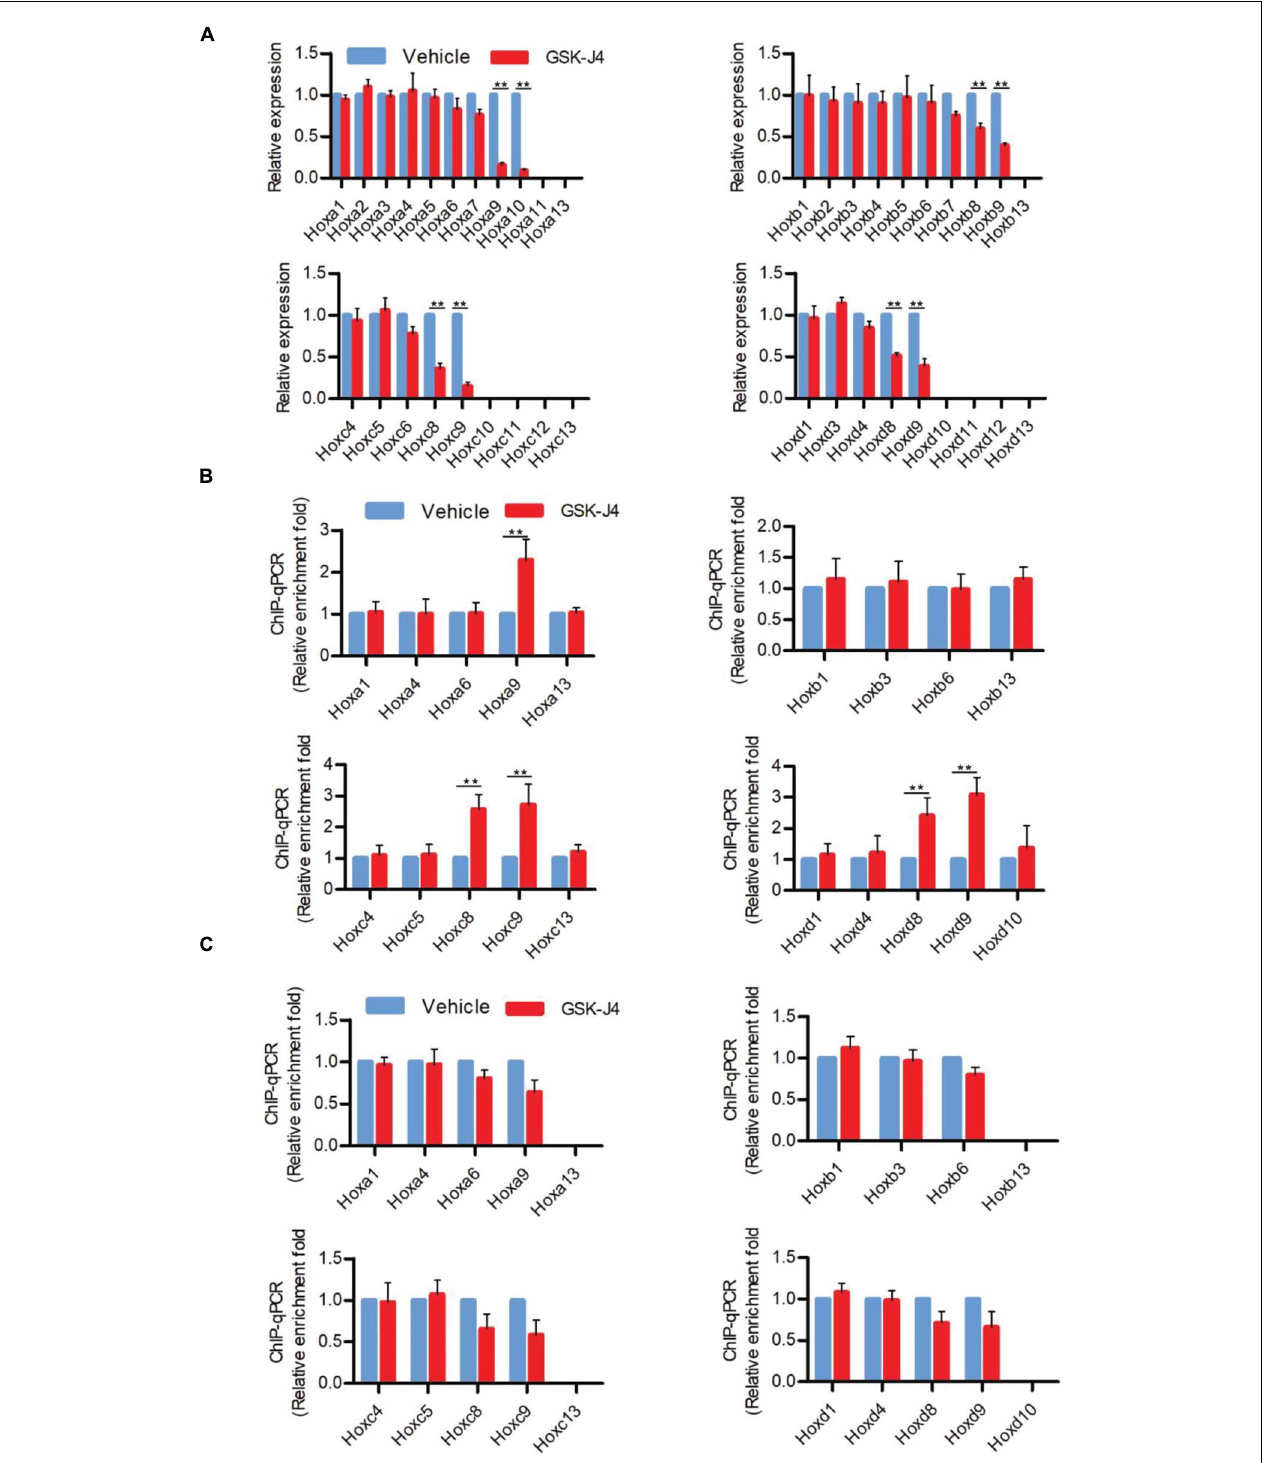
FIGURE 2 | GSK-J4 inhibits transcription of Hox genes by blocking the H3K27me3 demethylase activity of Jmjd3 in E8.5 mouse embryos. (A) The mRNA levels of Hox genes were determined by RT-qPCR in E8.5 embryos, which were treated by vehicle or GSK-J4 (50 mg/kg) 12 h before. (B,C) The ChIP-qPCR assays with antibodies specific for H3K27me3 (B) or Jmjd3 (C) on the Hox genes in E8.5 embryos, which were exposed to vehicle or GSK-J4 (50 mg/kg) 12 h before. Bars indicate triplicate PCR reactions ± SD. Representative results of three independent experiments are shown. * p < 0.05, ** p < 0.01.